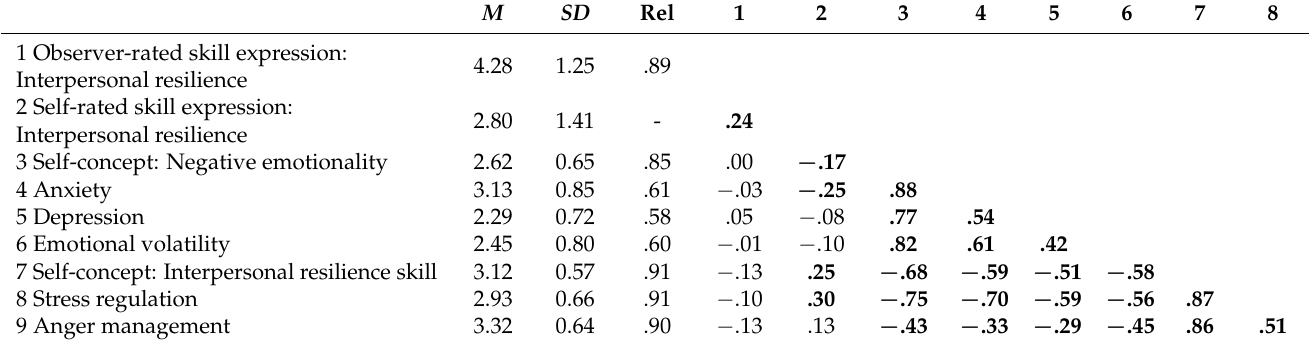
Table 5. Relationships of Skill Expression With Personality and Skill Self-Concepts: Interpersonal